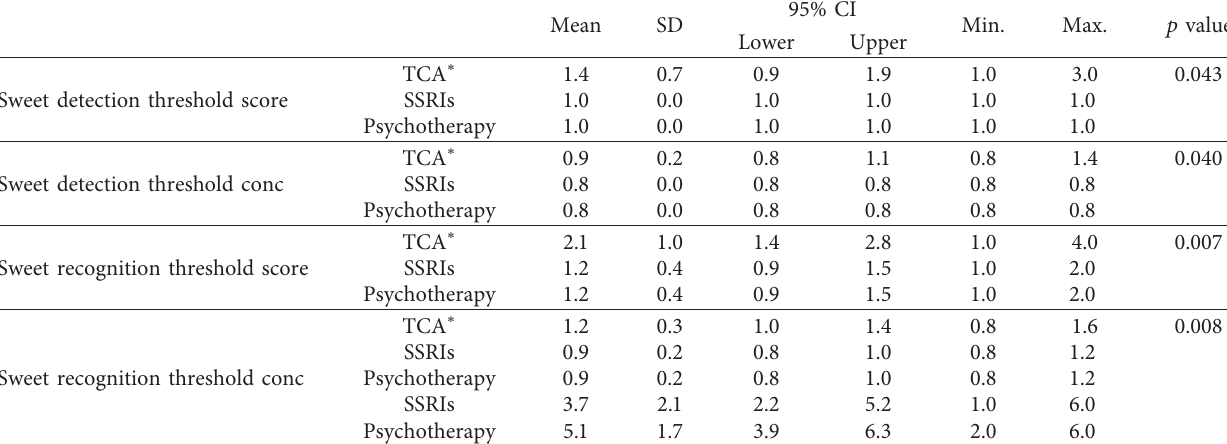
Table 2: Descriptive statistics and one-way ANOVA for sweet detection and recognition thresholds scores and concentrations among the tested